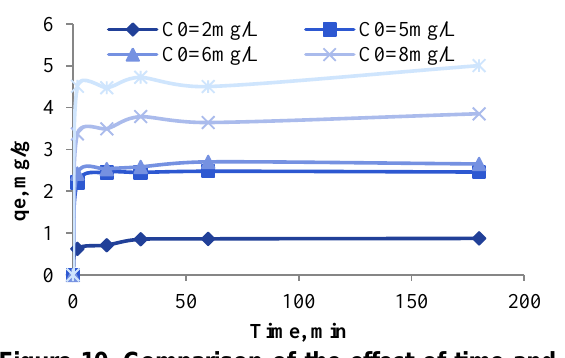
Figure 11. Langmuir (a) and Freundlich (b) adsorption isotherms of Cr and Cu ions using MCh/Fe-Zr nanoparticles in adsorbent dosage of 0.4 g/l for copper and 2 g/l for chromium, initial concentration of metal ions of 2-10 mg/l, temperature of 25 o C, Cu solution pH of 9 and Cr solution pH of 4